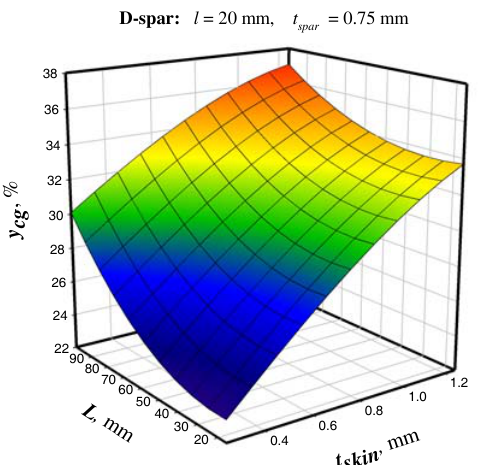
Fig 21. The dependences of gravity location on MFC chord-wise length and skin